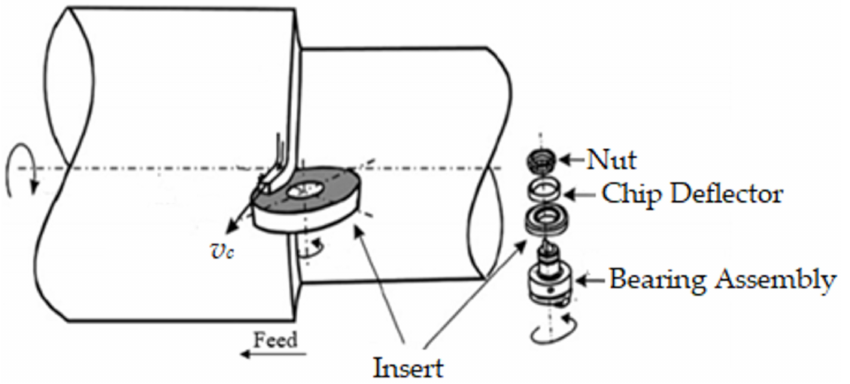
Figure 1. Characteristic rotary tool machining